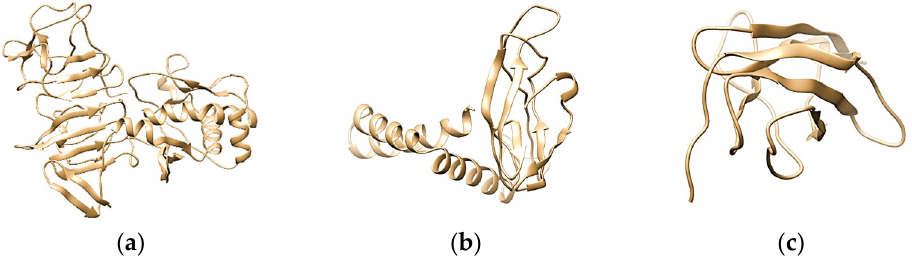
Figure 3. The 3D structure of ( a ) NS1; ( b ) prM; ( c ) EIII consensus proteins predicted by the trRosetta and visualized by UCSF chimera.